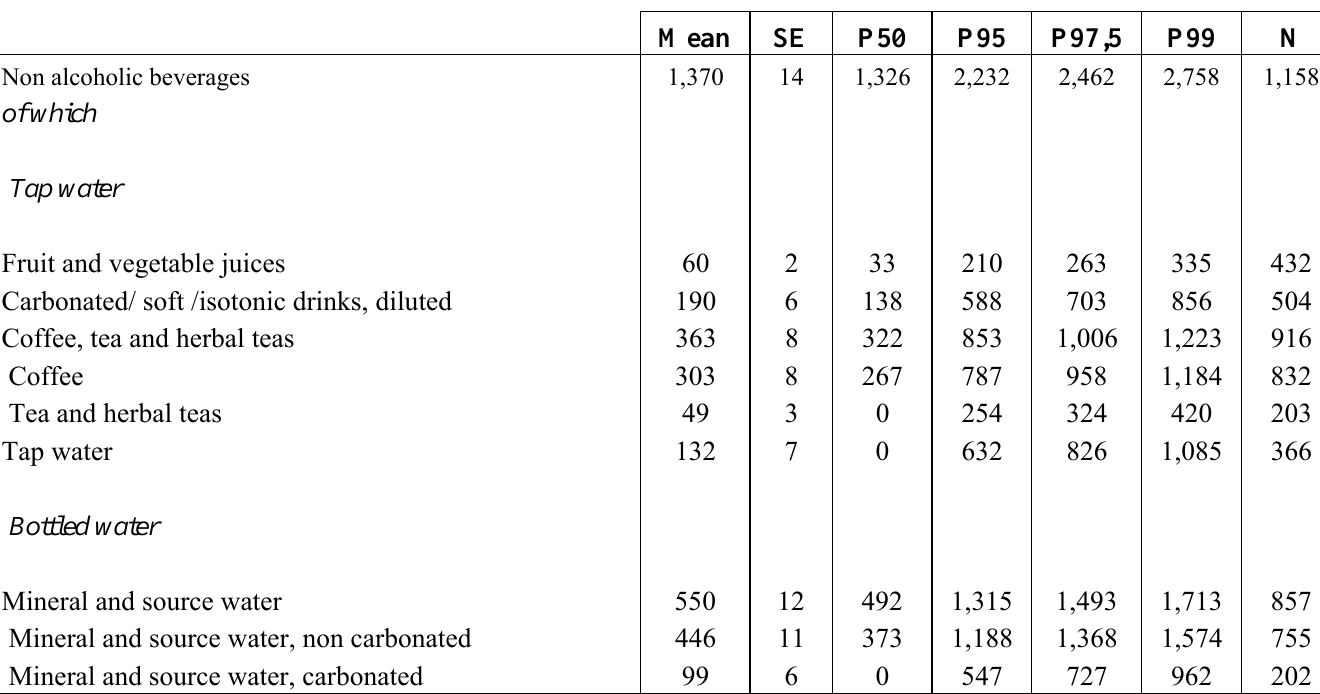
Table 2. Mean (SE, P50, P95, P97.5, P99) usual consumption of non-alcoholic beverages in the Walloon region (Brussels included), all days, entire adult population (mL/day) (Food consumption survey, 2004).